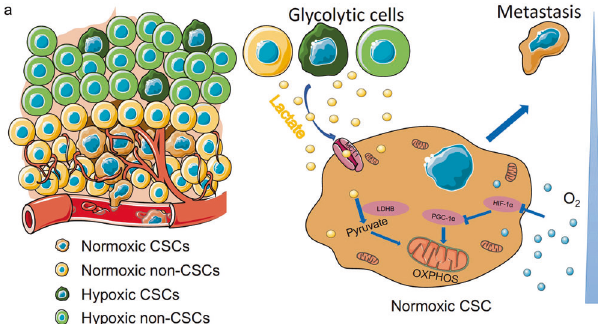
Fig. 7 TME-derived lactate promotes metastasis of normoxic CSCs depending on oxidative metabolism pathway. a Schematic illus- tration of the proposed model. Normoxic CSCs get more access to the blood vessels than hypoxic CSCs. Hypoxic cell-secreted lactate in the TME could be ingested by normoxic CSCs to promote their OXPHOS and thus enhance their metastatic